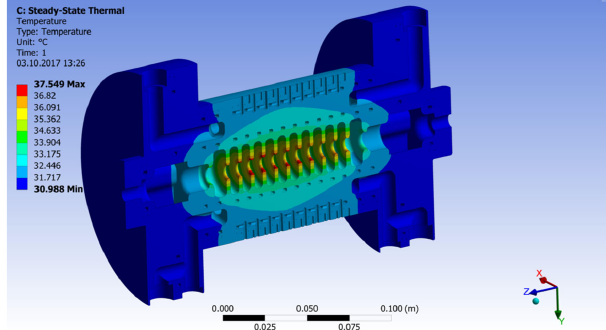
FIG. 19. Temperature distribution in a model with a few cells of the PolariX TDS for an inlet water temperature of 30 °C and dissipated average power of 3 kW.